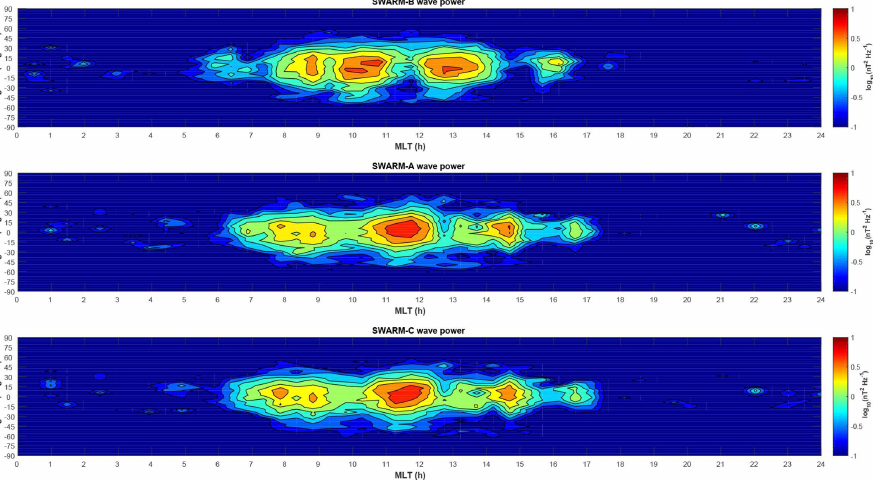
Figure 7. Swarm Pc3 wave powermap in magnetic coordinates. Pc3 wave power per second mapped on the magnetic latitude versus MLT grid. Source: Papadimitriou et al. 2018